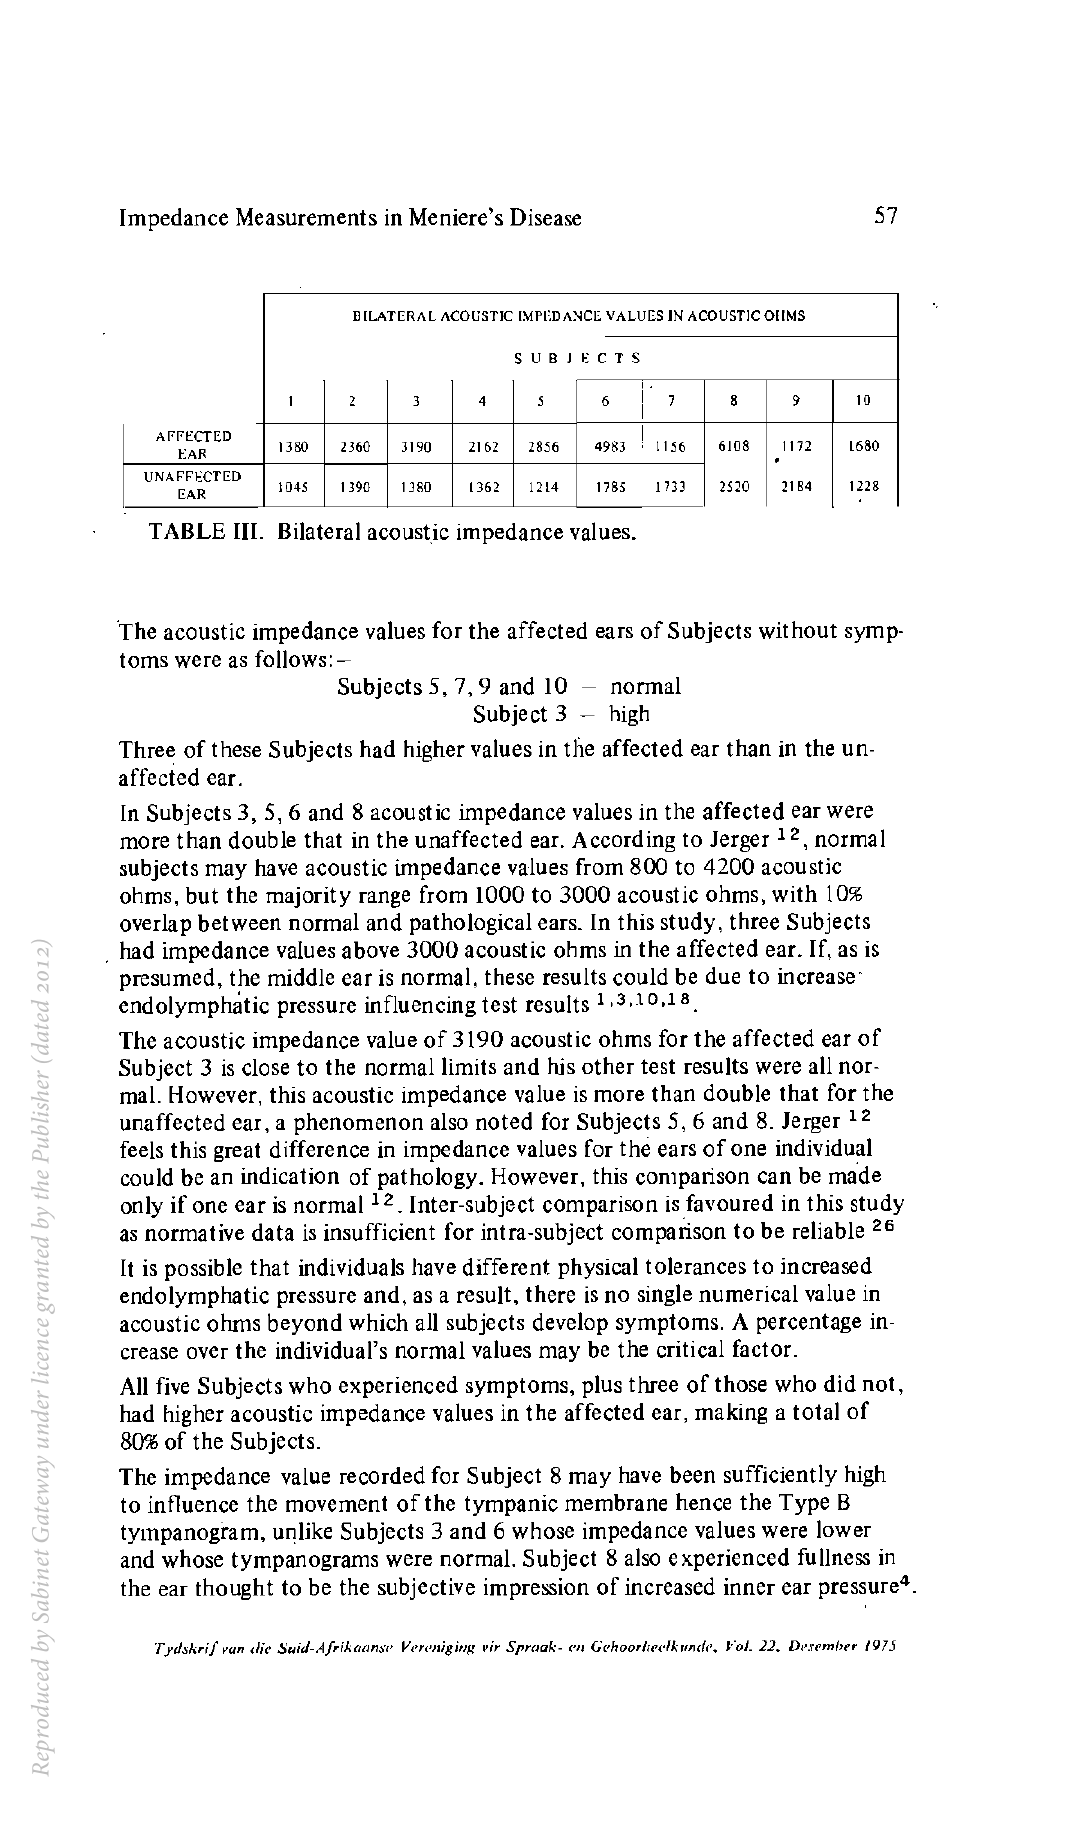
The acoustic impedance values for the affected ears of Subjects without symp- toms were as follows: